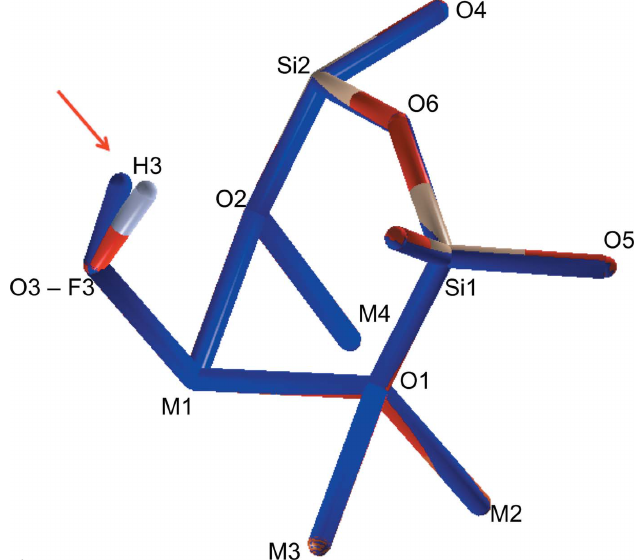
Figure 6 A view of the structure overlay of the refined structure of fibre_T (in colour) and fibre_C (monochromatic blue). The two structures strongly overlap on all the atomic positions; the largest distance between corresponding atoms ( i.e . 0.296 A˚ ) involves the hydrogen atoms (pointed out by the red arrow). In the case of fibre_T, the W site is characterized by an F substitution, and the atomic species partition for this site is 0.96 (3) for O and 0.04 (3) for F. The plots were designed using the SIR2019 software (Burla et al. ,